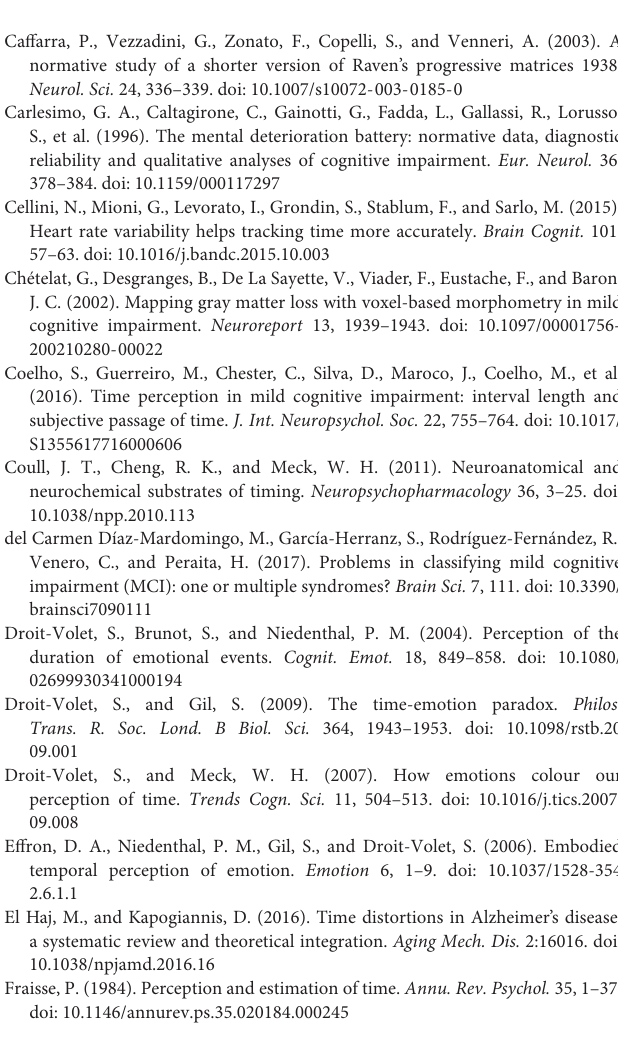
TABLE S2 | Neuropsychological